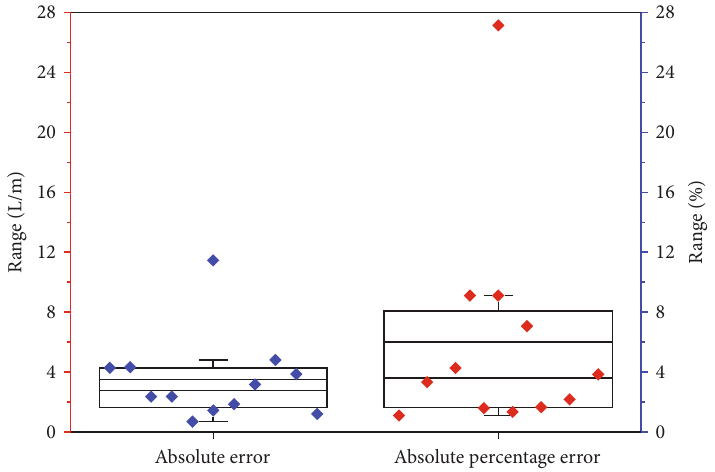
Figure 10: The prediction performance indicators of the